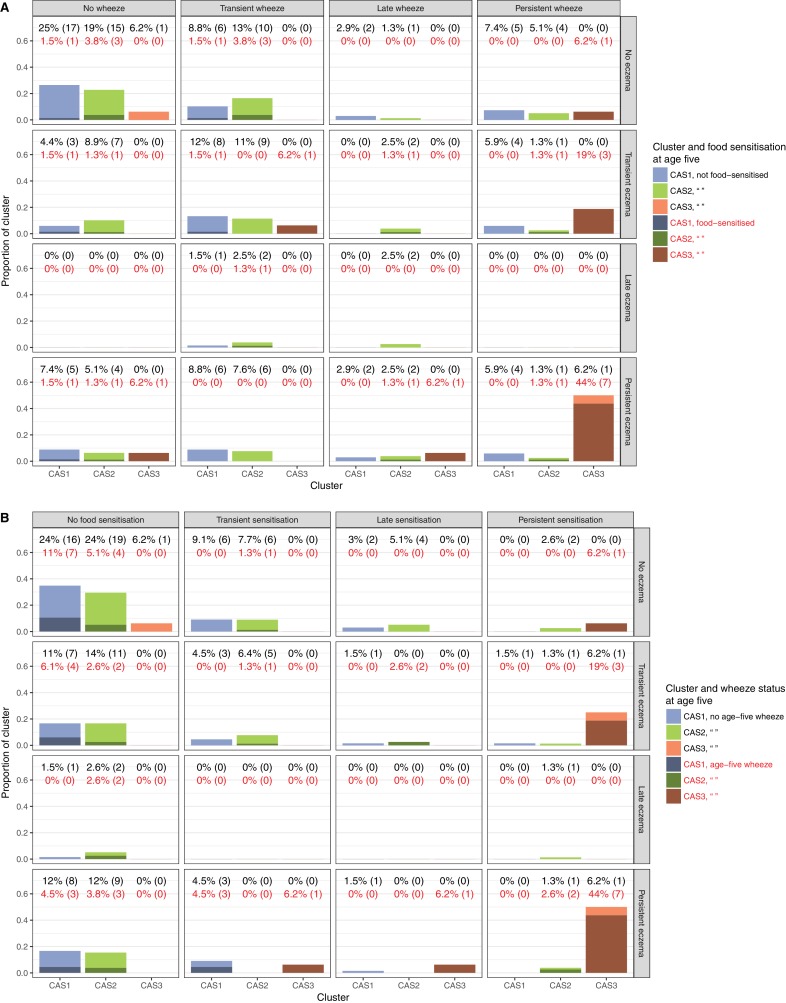
Relationship of clusters to food sensitisation, eczema and wheeze.Percentages denote proportion of cluster displaying phenotype (numbers in brackets denote actual sample numbers). Food sensitisation defined as peanut IgE ≥0.35 kU/L at any age, or cow’s milk, egg white, peanut SPT > 2 or 3 mm for age ≤2 or>2, respectively. Subphenotypes defined for food sensitisation, eczema and wheeze as: no phenotype = phenotype absent at all ages; transient = any incidence of phenotype at the earlier ages (1 to 3 for wheeze, 6 m to three for eczema, 6 m to two for sensitisation), but not age 5; late = phenotype at age 5, but not the earlier ages; persistent = any incidence of phenotype at both earlier ages and age 5.